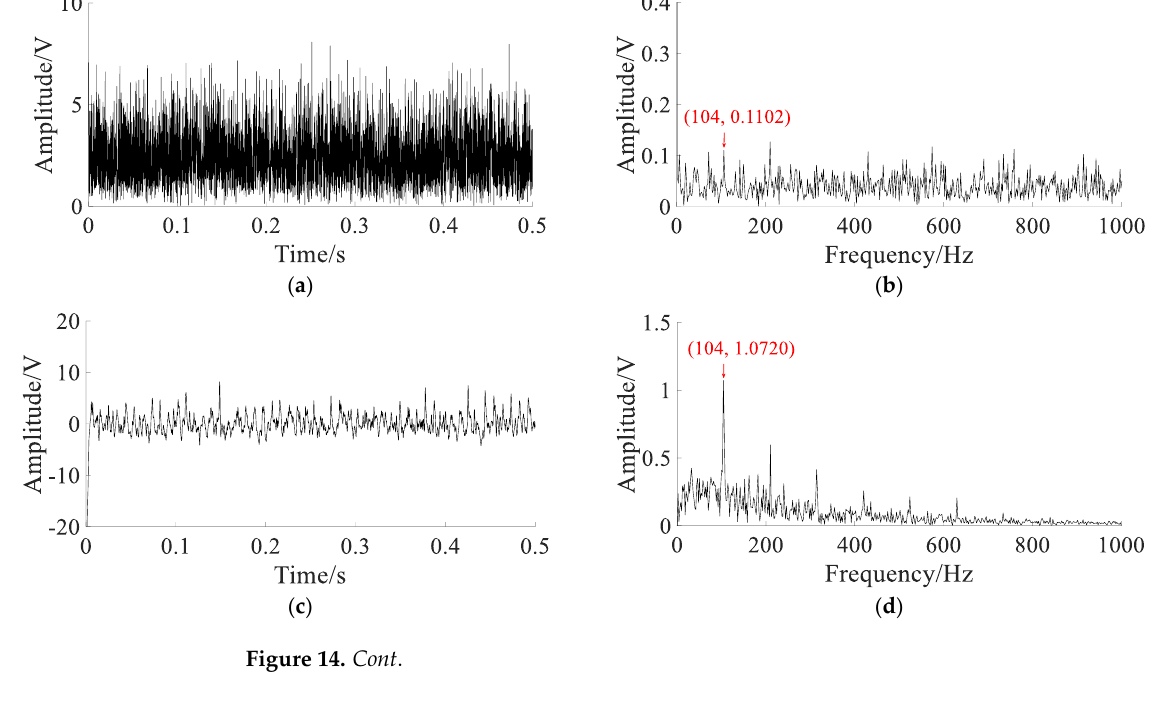
Figure 14. The results of different methods: ( a ) Hilbert transform envelope demodulation signal; ( b ) Hilbert envelope spectrum; ( c ) output signal of SGST adaptive SR: